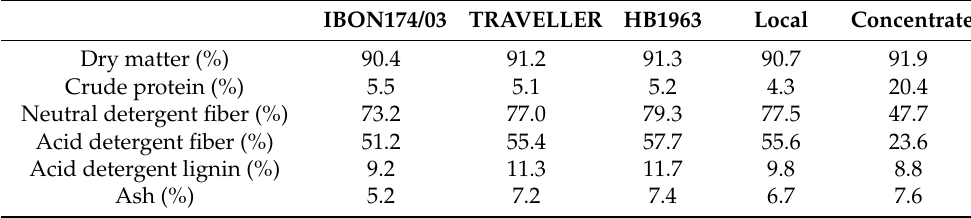
Table 2. Nutrient composition of the barley straw varieties and concentrate mixture used in the